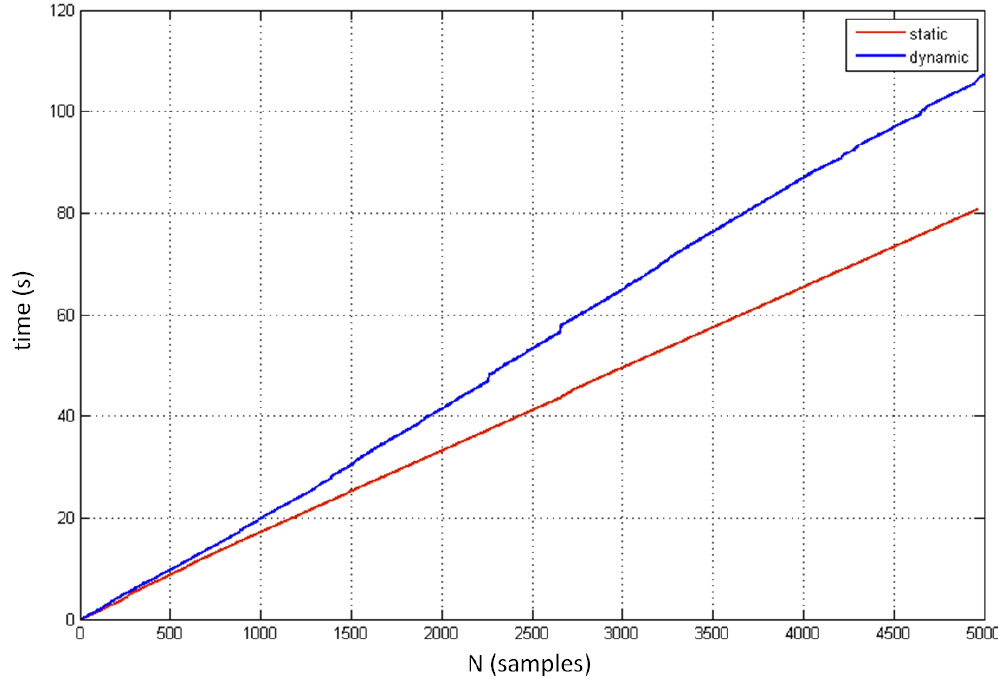
Figure 14. Comparison between the progress of static and dynamic measurements (total time required to collect the initial 5,000